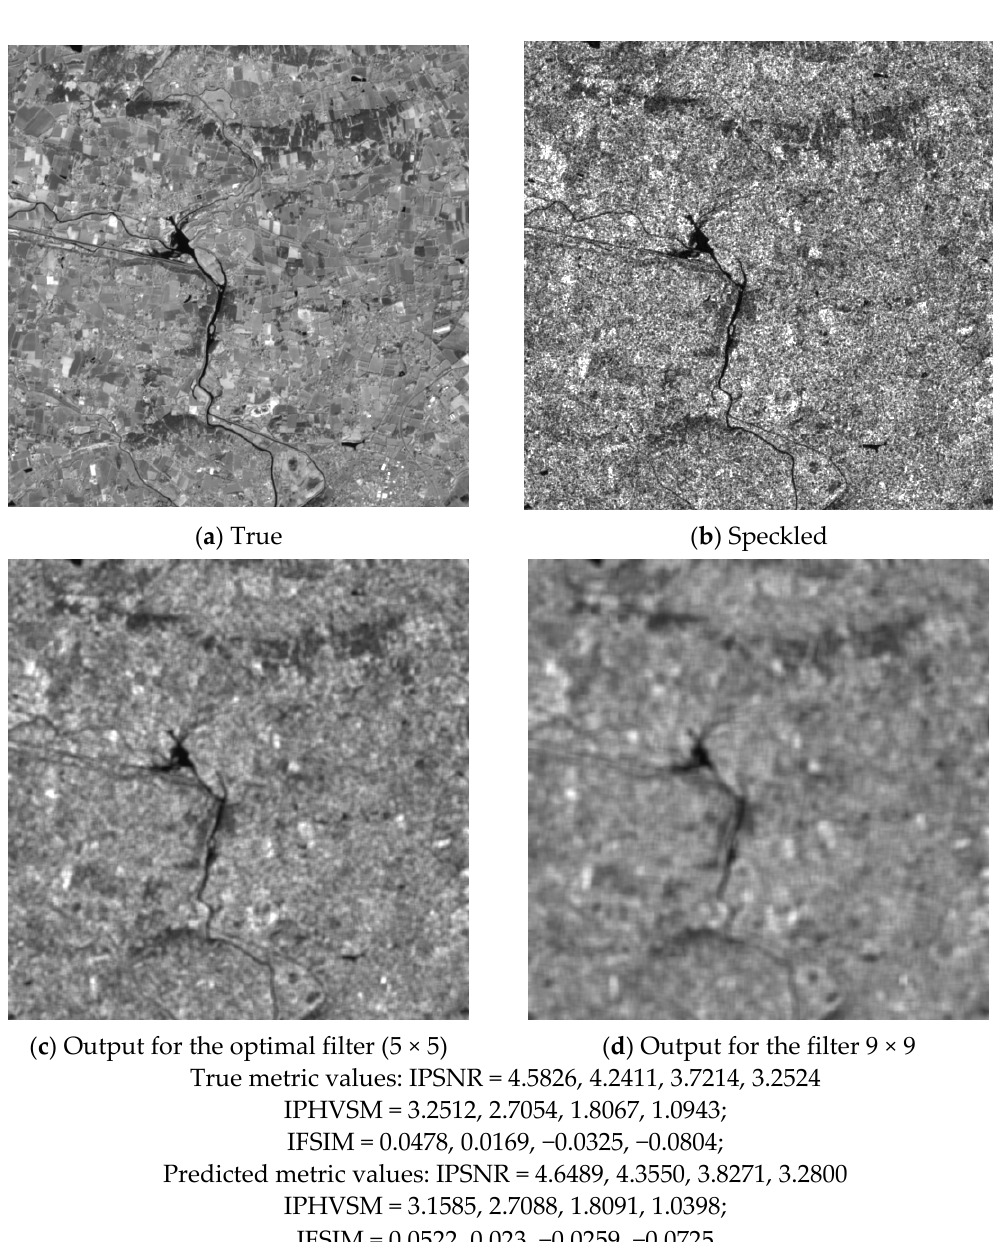
Figure 17. The true image ( a ); the speckled image ( b ); the optimal filter output for the 5 × 5 scanning window ( c ); and the filter output for the 9 × 9 scanning window ( d ).